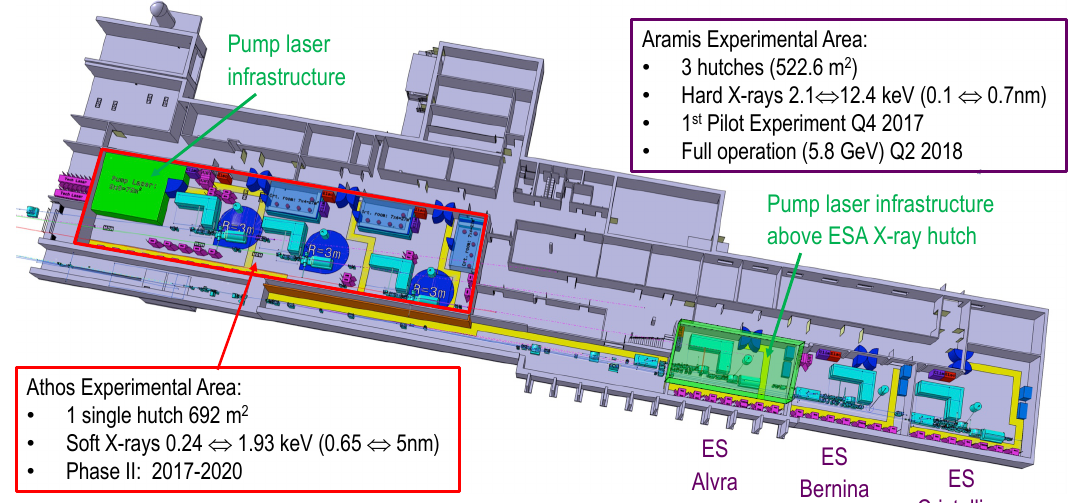
Figure 12. The experimental areas of SwissFEL. The accelerator is to the left of the above area, with the X-rays travelling from left to